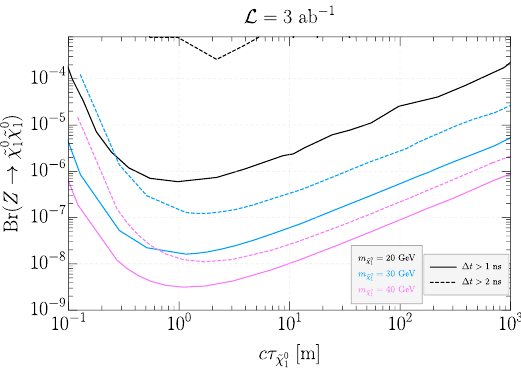
Figure 8 . Sensitivity reach shown in the plane Br( Z → ˜ χ 0